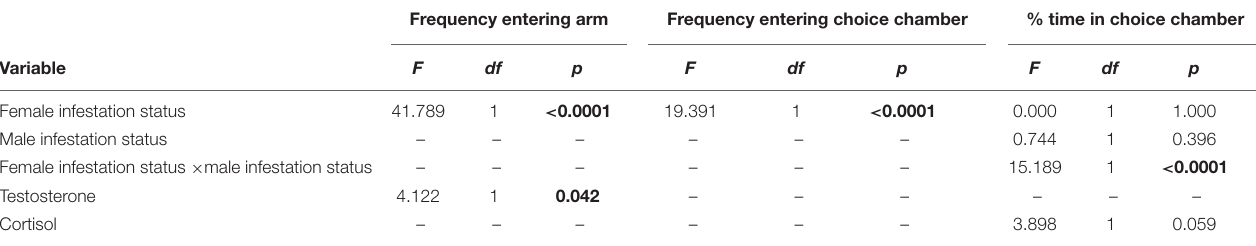
TABLE 1 | Final models for the effects of female and male infestation status and hormone levels on female C. h. pretoriae preferences.